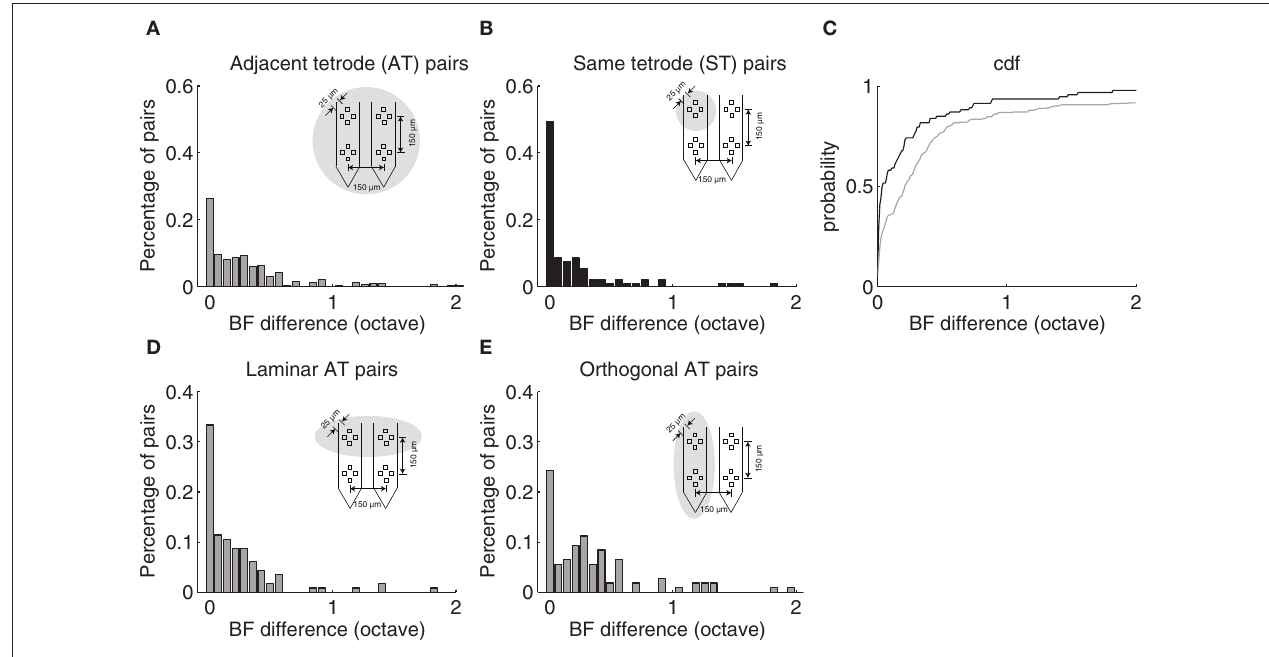
distribution function for same ( black ) and adjacent ( gray ) tetrode neuron pairs. (D) BF difference distribution for neuron pairs isolated on adjacent tetrodes that are along the ICC lamina orientation. (E) The distribution for neuron pairs isolated on adjacent tetrodes that are orthogonal to the lamina orientation. A significant mode is observed at ∼ 0.28 octave consistent with the average BF difference between adjacent